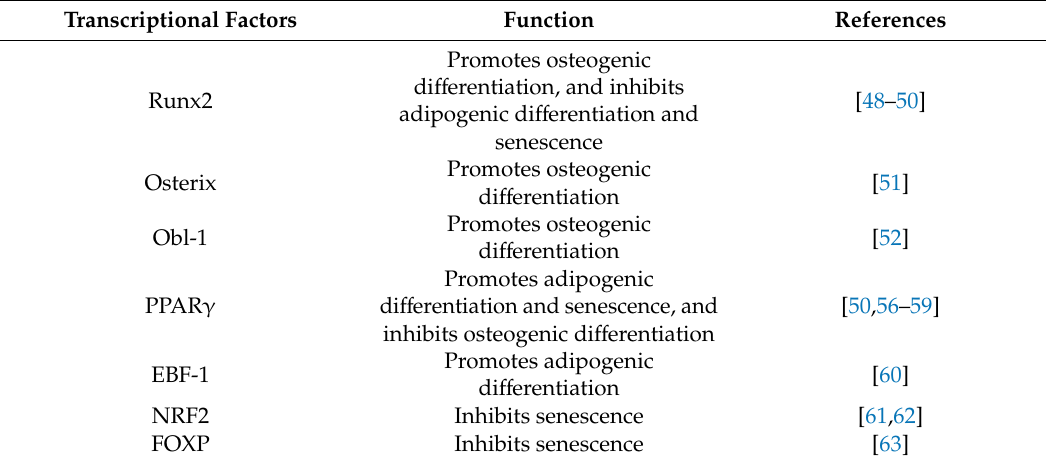
Table 1. Transcriptional factors involved in di ff erentiation and senescence of